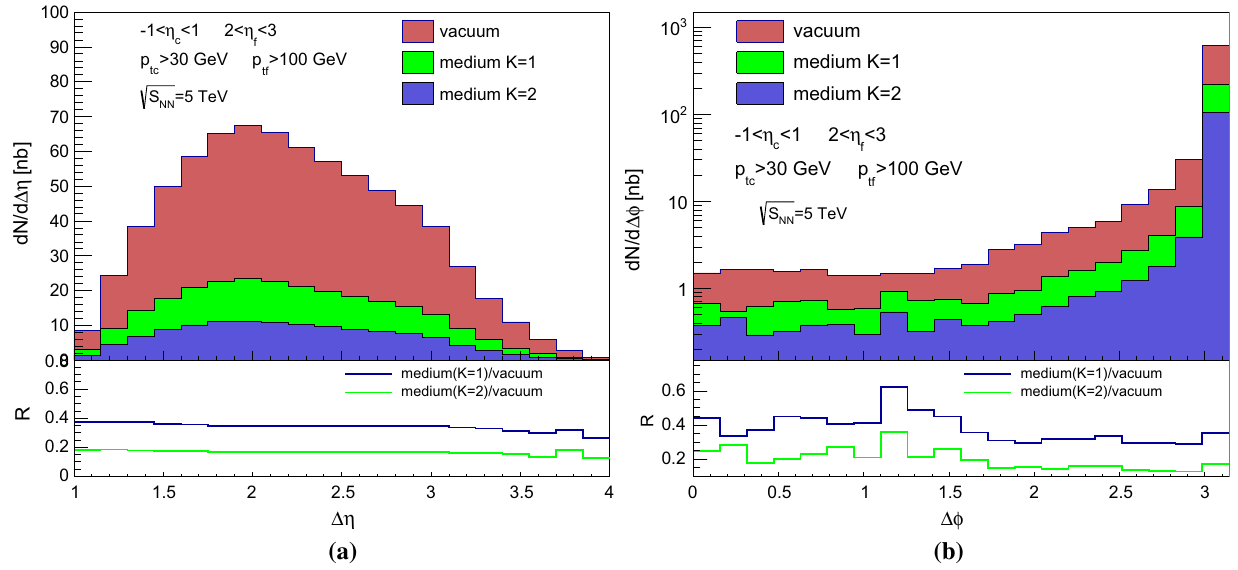
jets (cid:3)φ before and after the jets pass through the medium. The red his- togram represents the (cid:3)φ of the jet without passing the medium. The dark green histogram represents the (cid:3)φ spectrum of a jet quenched by the medium with K = 1. The green histogram represents the (cid:3)φ spectrum of a jet quenched by the medium with K = 2. Bottom: Ratios of the histograms